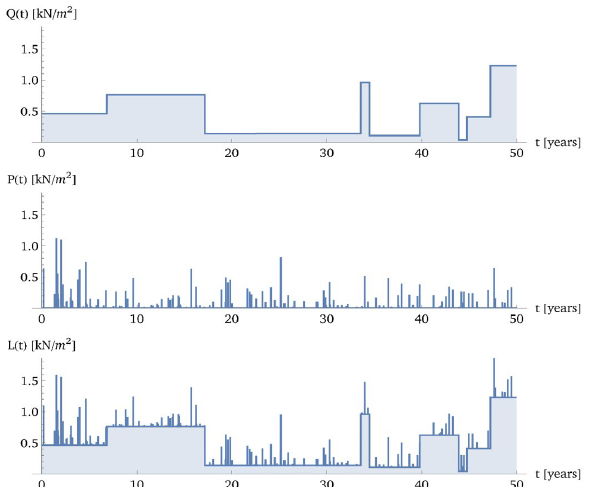
Figure 3. Time histories of one sample of sustained, extraordinary and total live load for an office floor with